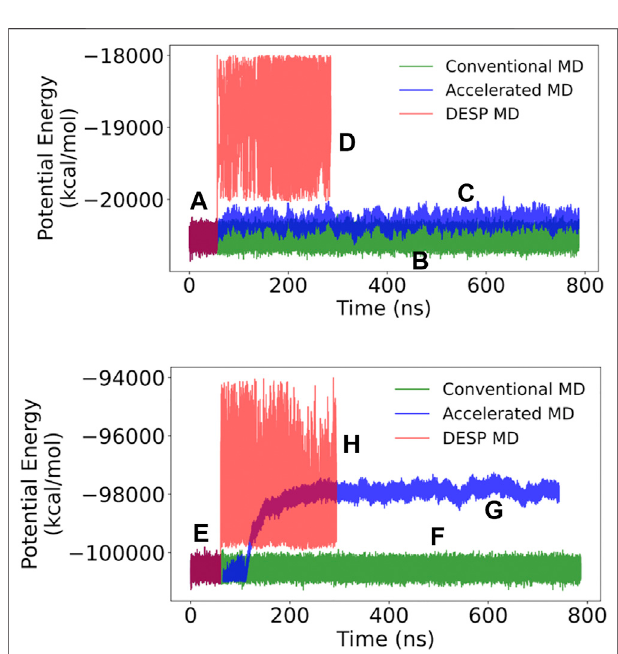
FIGURE 6 | The potential energy for A 12 (top) and GB98 (bottom) molecular systems. (A and E) The initial stages of DESP (as well as the initial stages of accelerated) MD simulations are identical to conventional MD simulations and have identicalsystems ’ potentialenergies. (BandF) Thetrajectoriesofthepotential energyfortheconventionalMDsimulationsareshowningreen; (CandG) thosefor the accelerated MD simulations are shown in blue; while (D and H) those for the DESP MD simulations are shown in red.